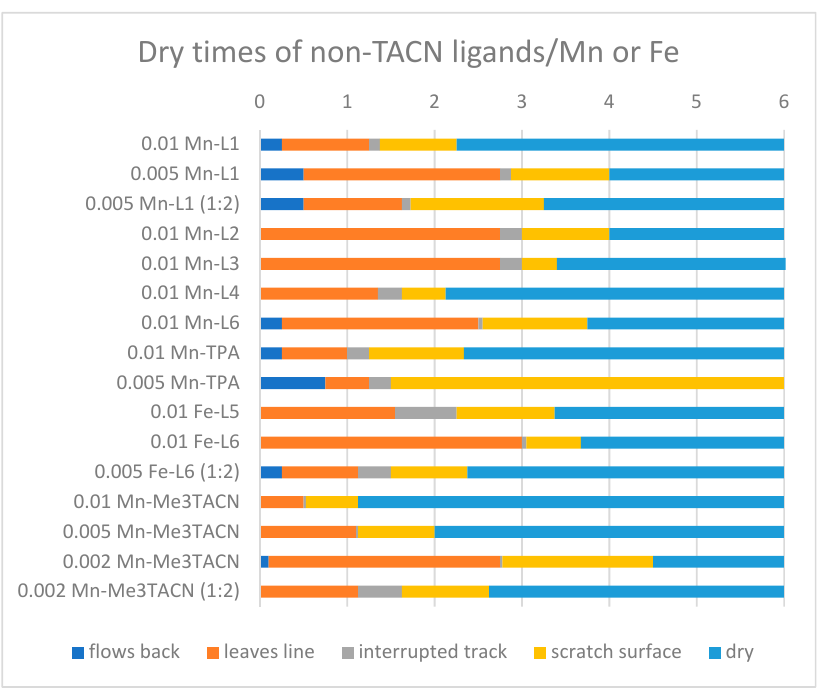
Figure 15. Alkyd resin curing activity of the ligands L1–L6, Me 3 TACN, and TPA mixed with either Mn II (EH) 2 (abbr. as Mn) or FeCl 2 (abbr. as Fe). The numbers of the ligands refer to the structures given